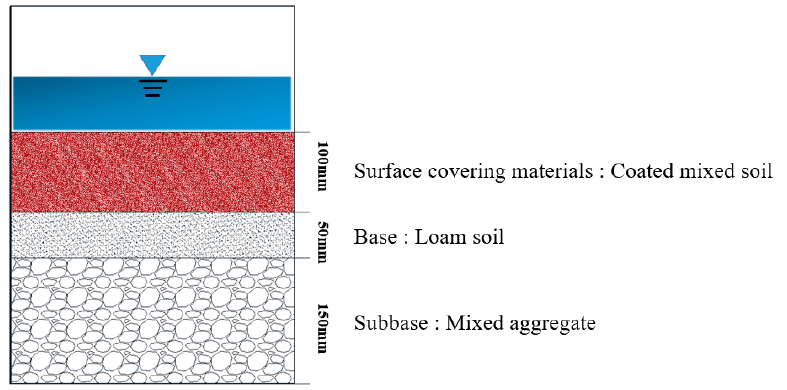
Figure 3. Simulated Permeability Test.